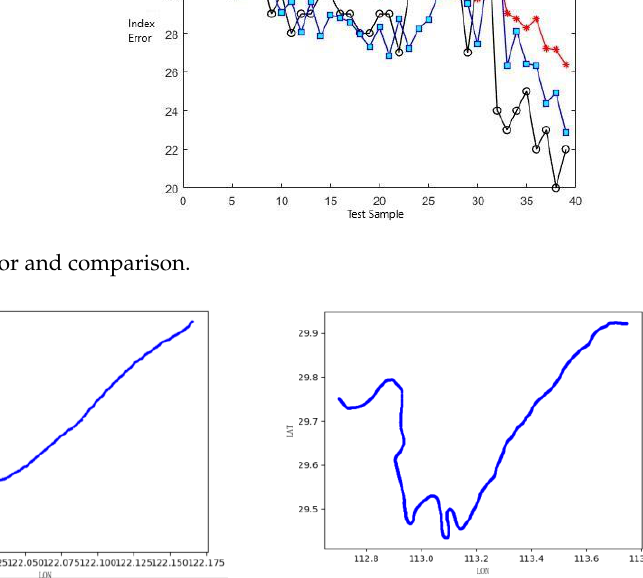
Figure 8. Speed prediction error and comparison.